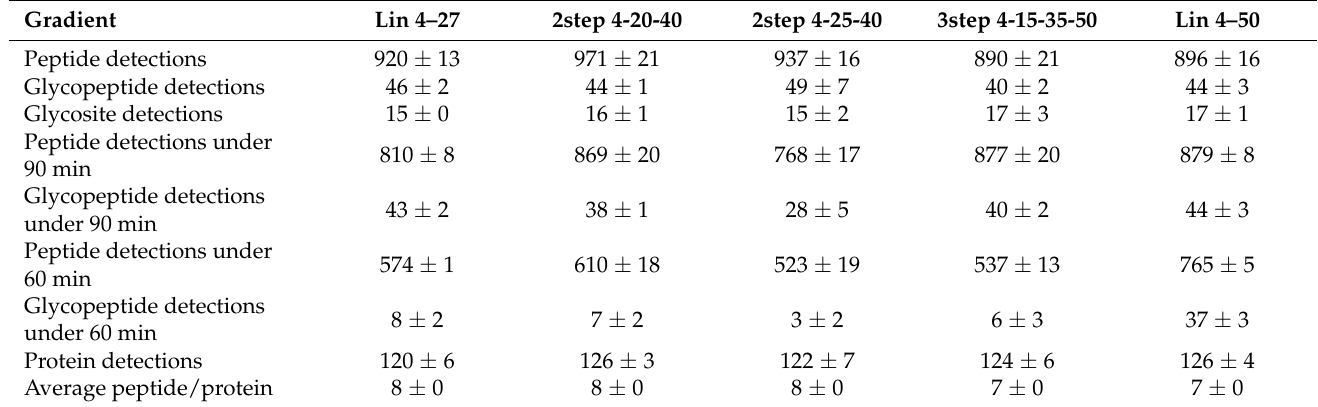
Table 3. Summary of detection values for different species for the compared gradient